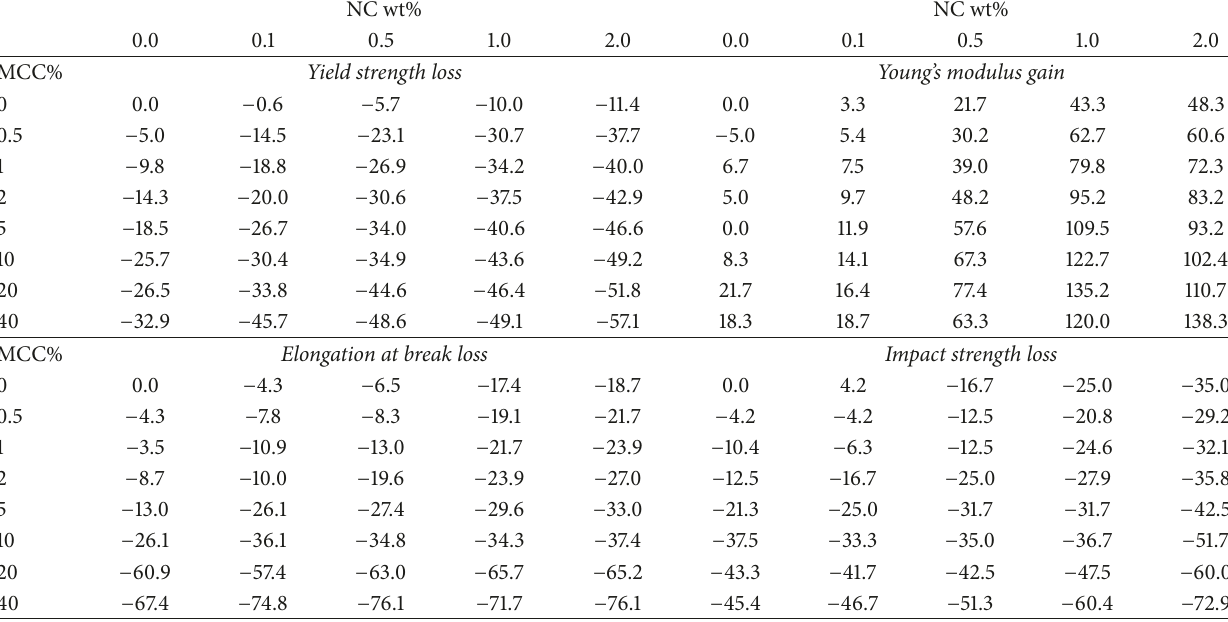
Table 2: Yield strength, elongation at break, and impact strength % loss and Young’s modulus % gain of polypropylene/nanoclay as a function of MCC